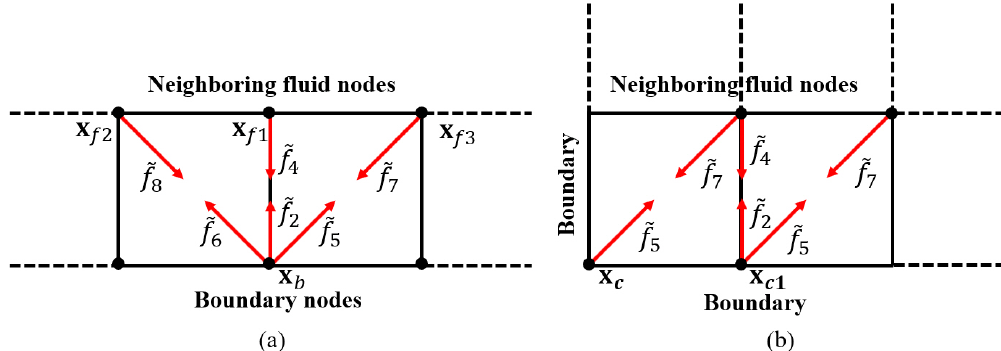
Figure 2. Schematic of post-collision distribution functions on different boundary nodes: ( a ) boundary nodes far away from the corner; ( b ) corner node and boundary node adjacent to the